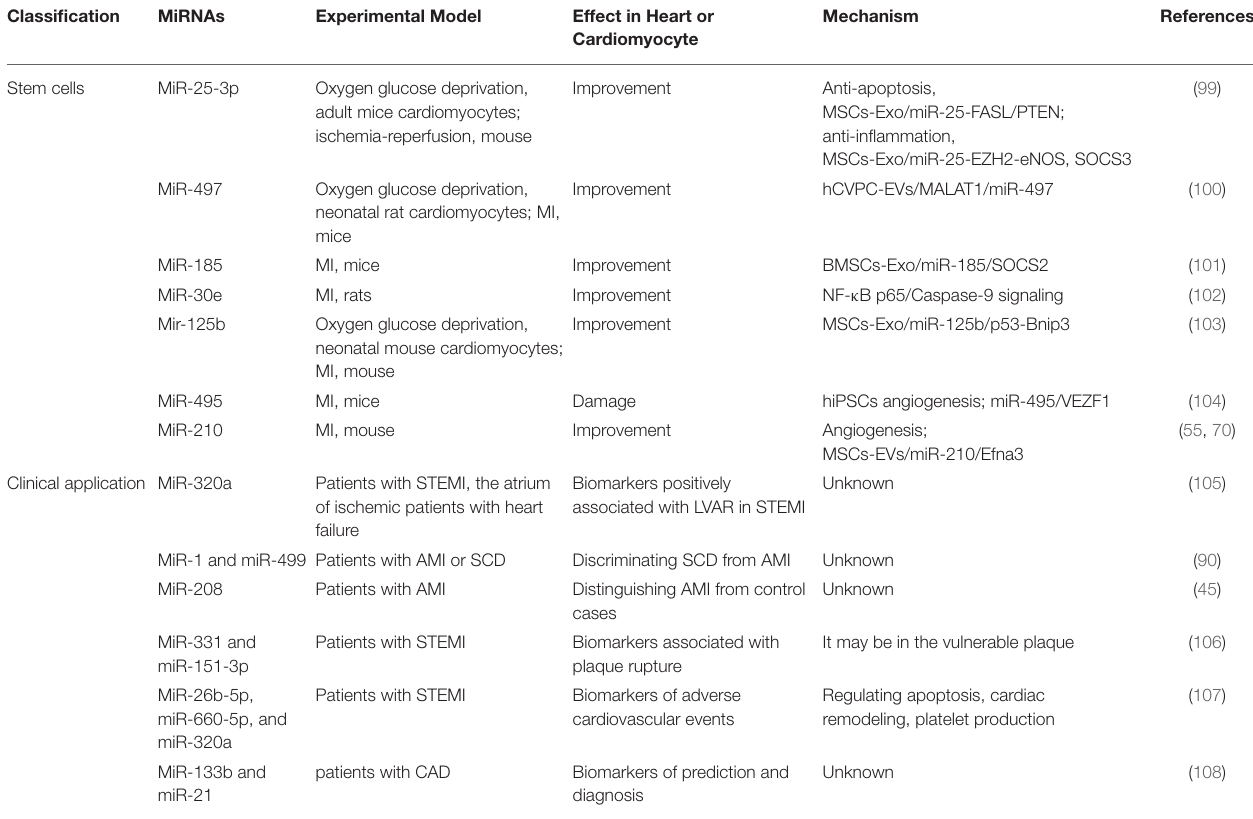
TABLE 6 | Summary of studies on miRNA’s involvement in the diagnosis and treatment of MI in the past 5